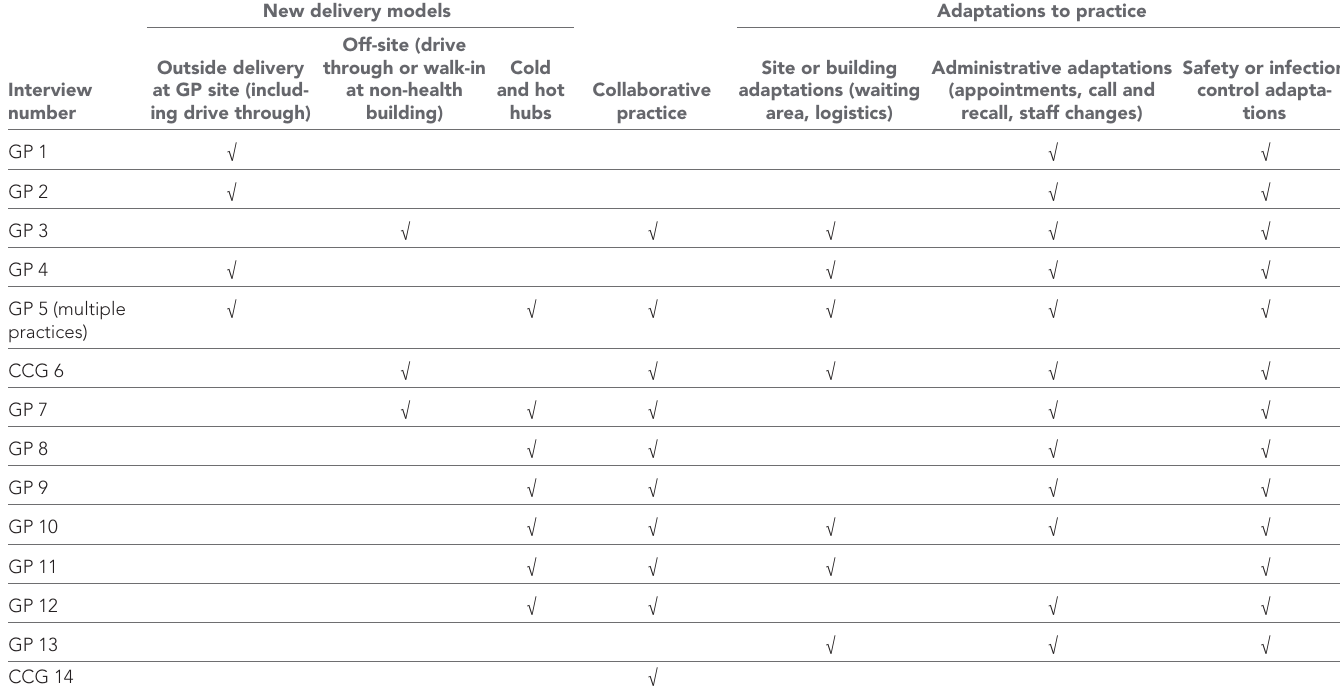
Table 2 New delivery models and adaptations to practices used by different practices